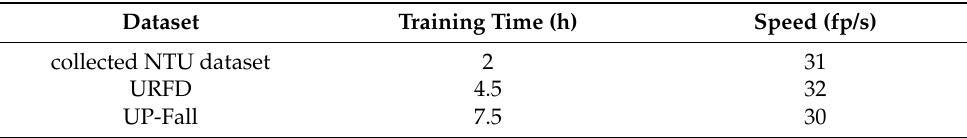
Table 6. Time and memory cost analysis on the three